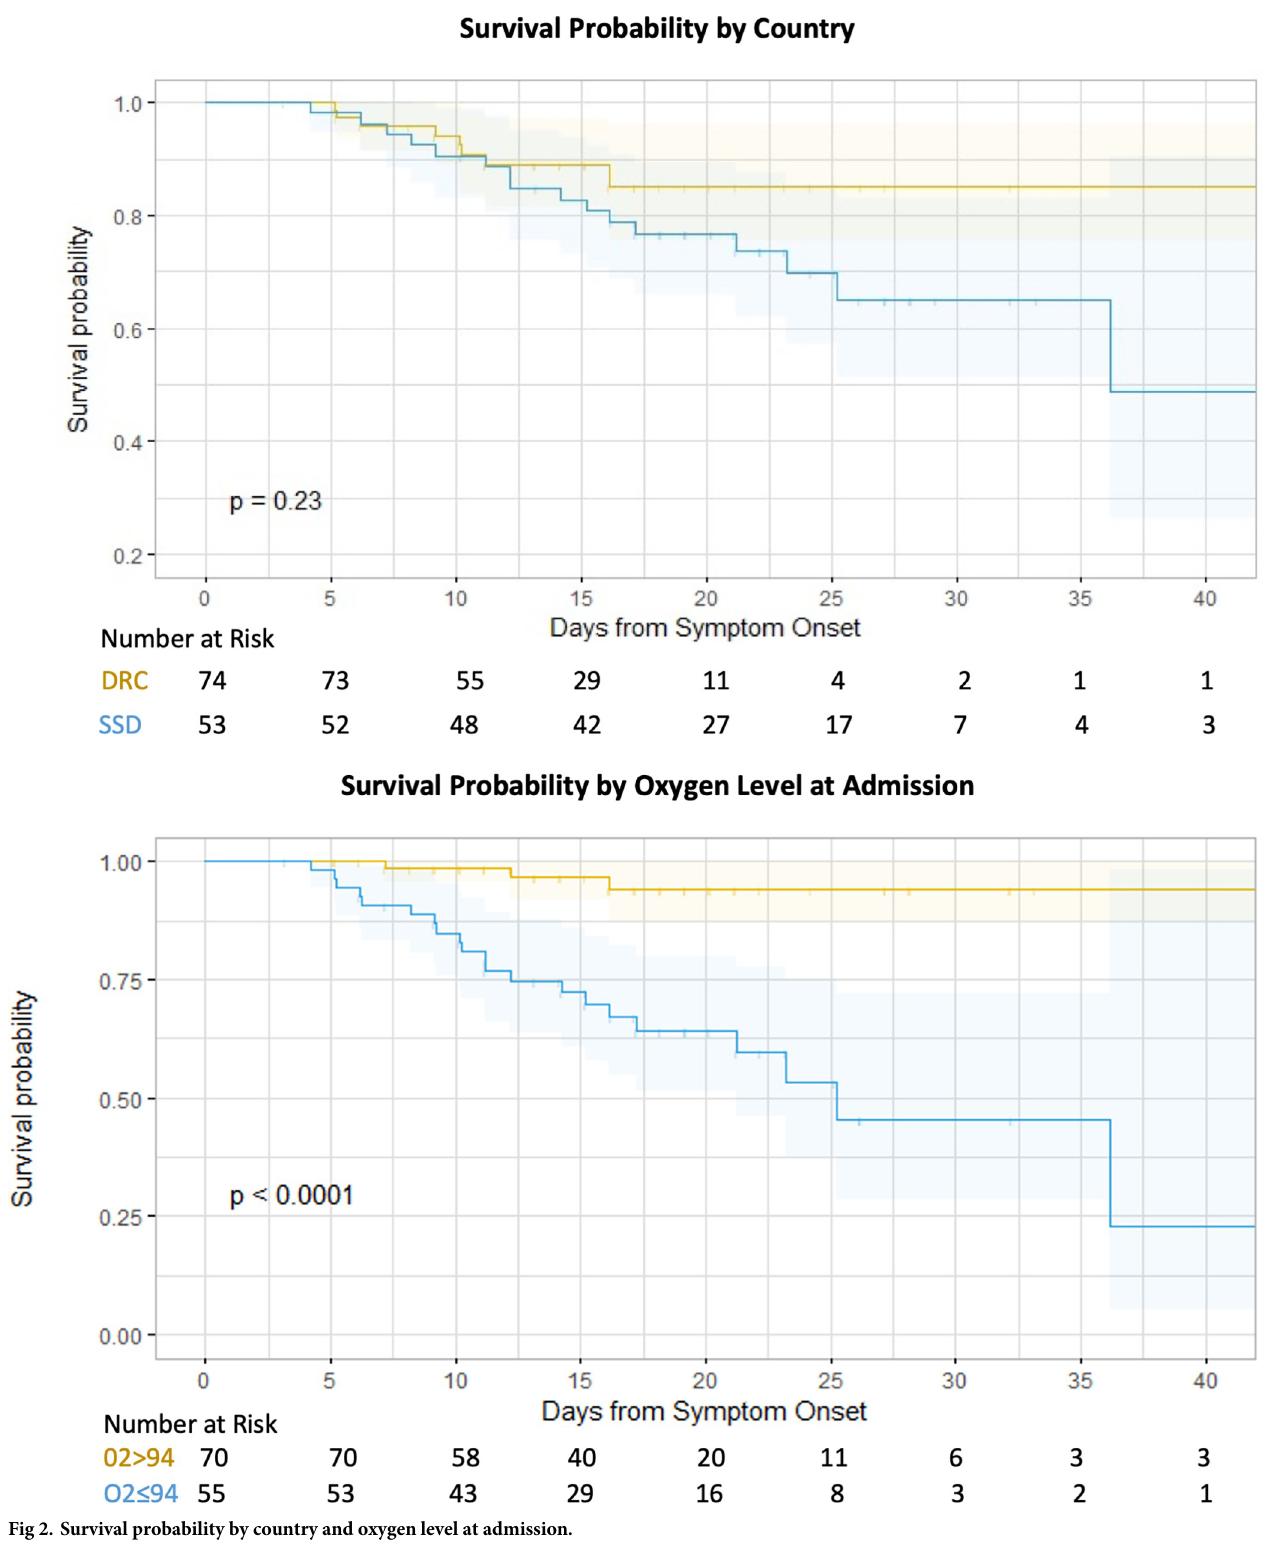
PLOS Global PublicHealth | https://doi.org/10.1371/journal.pgph.0000924 October 19,